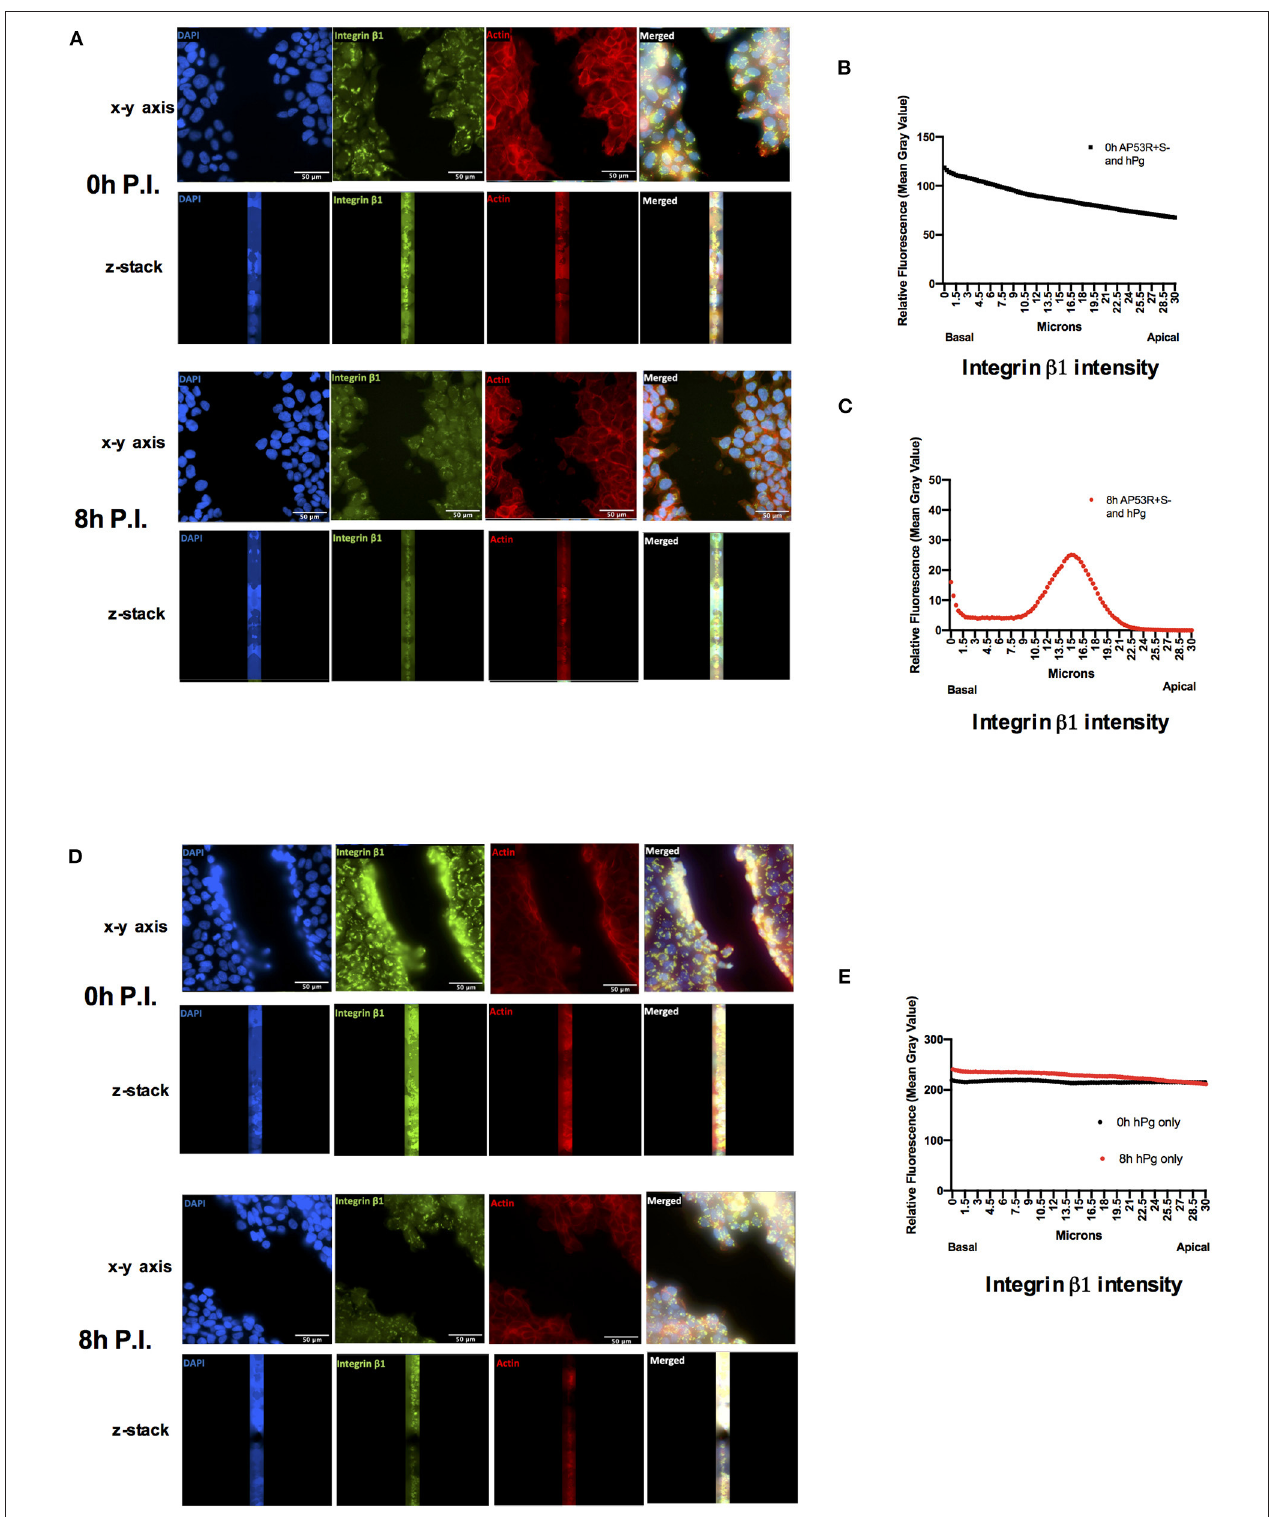
FIGURE 7 | Activation of hPg by AP53R + S − promotes relocalization of integrin β 1 into the cytoplasm of a keratinocyte wound. Scratch wounds are imaged as in Figure 1 . (A) Cells were incubated with AP53R + S − at MOI 5 along with the addition of 7 µ g/ml hPg prior to fluorescence imaging at 0 and 8h. (B,C) Fluorescence readings for an antibody to integrin β 1 were analyzed for each image via ImageJ/Fiji after infection with GAS and hPg. The black lines indicate aggregate fluorescence